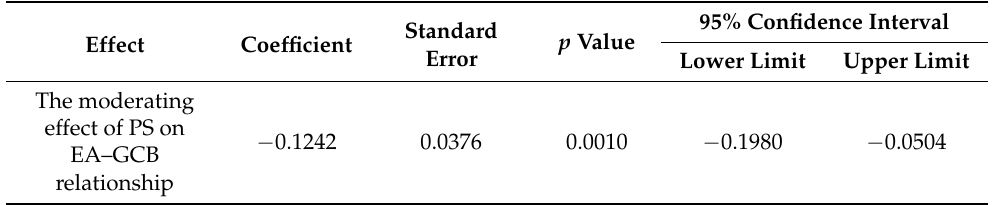
The moderating − 0.1242 0.0376 0.0010 − 0.1980 − 0.0504 EA–GCB relationship